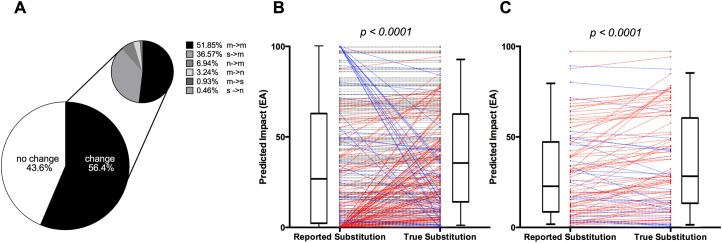
Impact of codon-level germline-somatic variant co-occurrences on prediction accuracy.(A) Representation of different types of incorrect variant predictions. If the amino acid substitution given by somatic calling was not changed by considering the germline context, the interaction was considered to be ‘no change’. If there was a change, data was split by whether it changed to a nonsense (n), silent (s), or different missense (m) substitution. (B) Paired EA impact of all co-occurrence events. Blue lines indicate pairs in which the reported substitution overestimated impact, red lines indicate pairs which the reported substitution underestimated impact, and grey indicates no change. Adjacent box plots show distributions of overall groups. (C) Paired EA impact of all co-occurrence events in which one missense substitution was incorrectly called as another. Blue lines indicate pairs in which the reported substitution overestimated impact and red lines indicate pairs which the reported substitution underestimated impact. Adjacent box plots show distributions of overall groups.